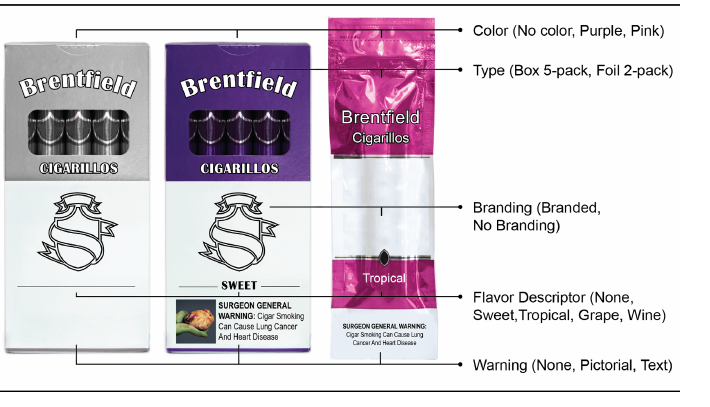
Fig 1. Cigarillo pack